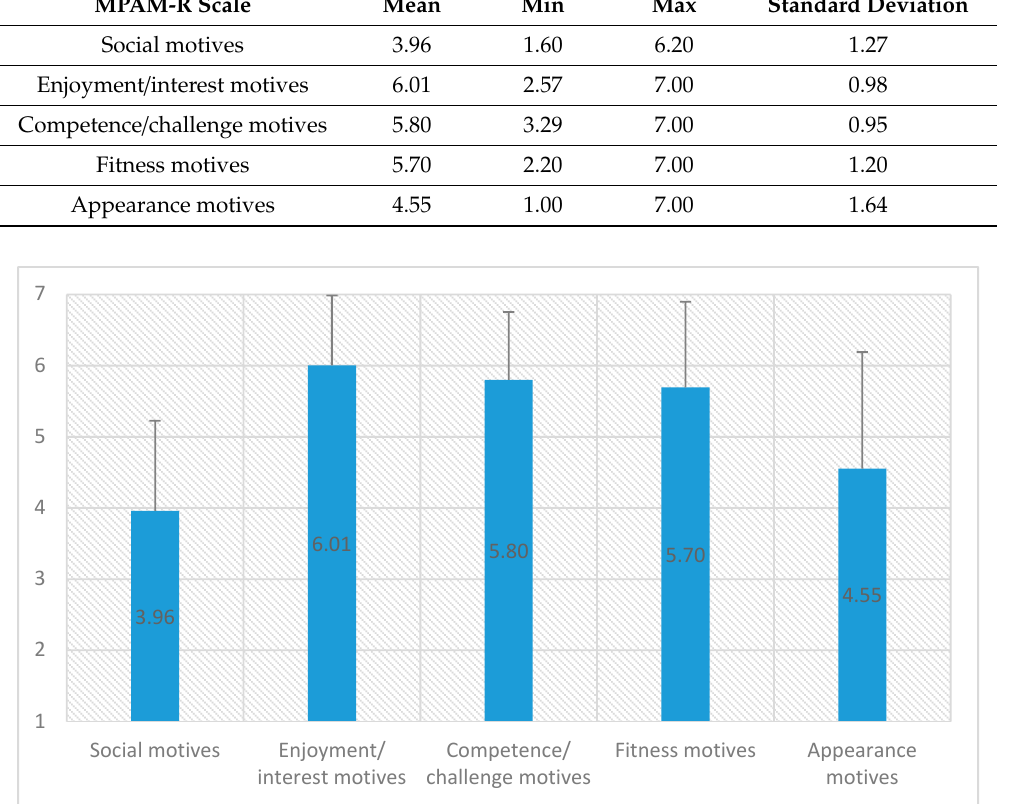
Table 1. Motives of the surveyed children. MPAM-R: Motives for Physical Activity Measure–Revised.